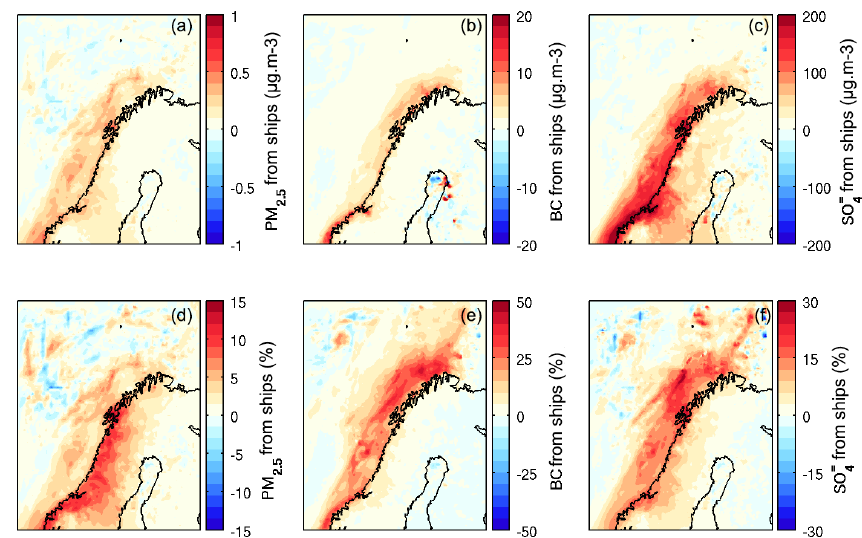
Figure 10. 15-day average (00:00UTC 11 July 2012 to 00:00UTC 26 July 2012) of (top) absolute and (bottom) relative surface enhancements (CTRL – NOSHIPS) in (a, d) PM 2 . 5 , (b, e) BC and (c, f) SO = due to ship emissions in northern Norway from 4